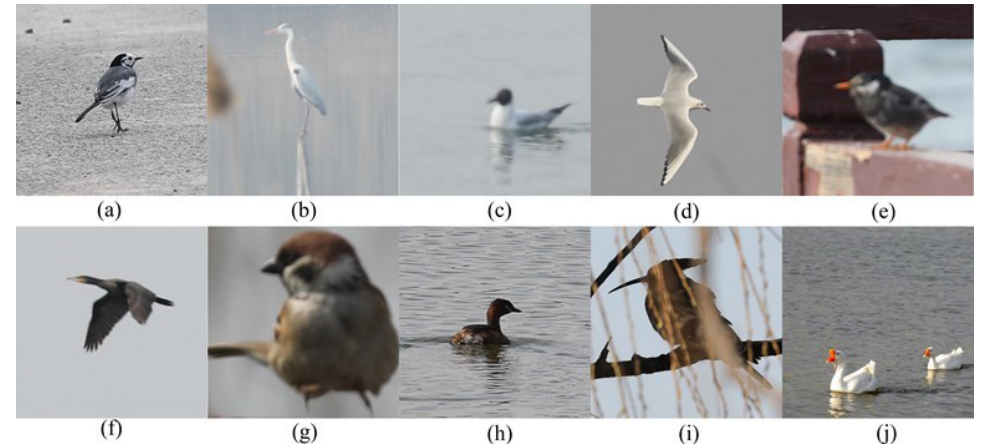
Figure 5. Sample of bird dataset.It includes 10 categories. Wherein, ( a ) is a picture of motacilla Alba; ( b ) is a picture of egrets; ( c ) is a picture of saunders’s gull; ( d ) is a picture of a seagull; ( e ) is a picture of the Greyhound; ( f ) is a photograph of cormorant; ( g ) is a picture of a sparrow; ( h ) is a picture of a little dog; ( i ) is a picture of a woodpecker; ( j ) is a picture of a white